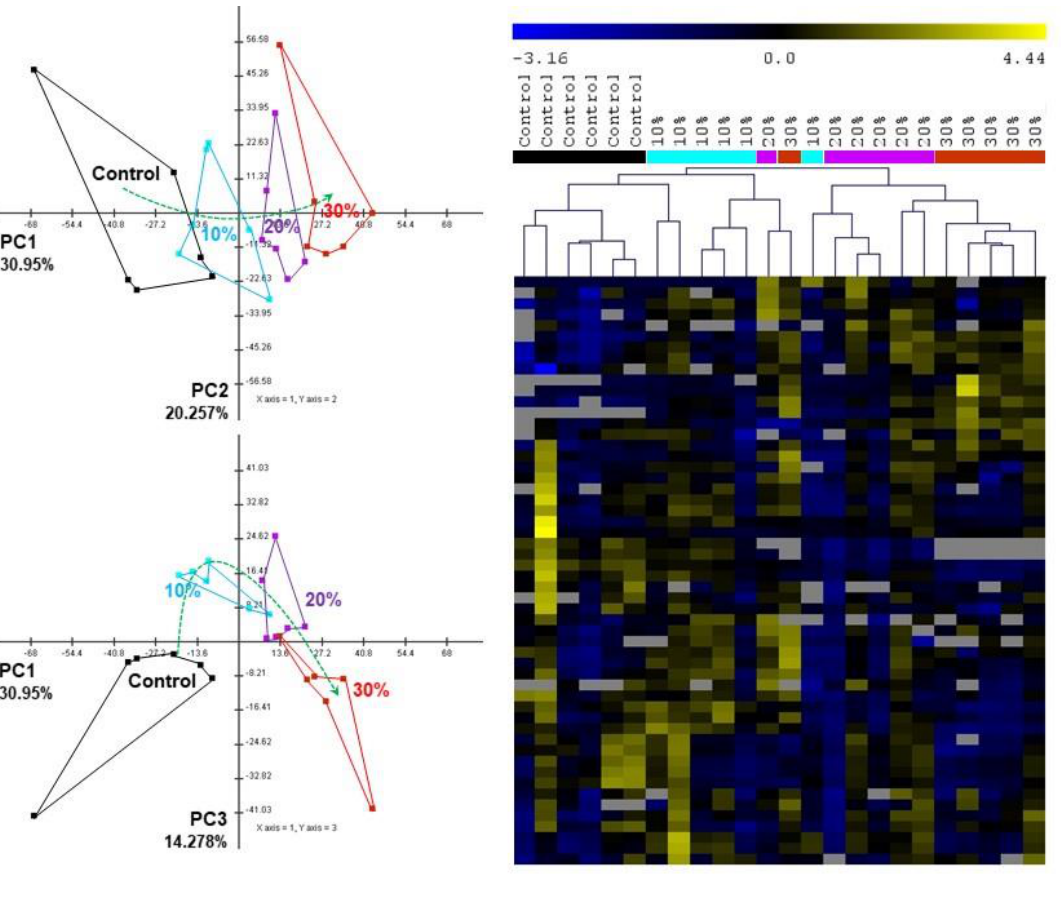
Figure 4. Multivariate statistical analysis of metabolomic data. PCA analysis and HCL shows the grouping and clustering of samples. The green arrow in PCA shows the gradual change in the metabolic profiles following the intensity of the mixture stress.